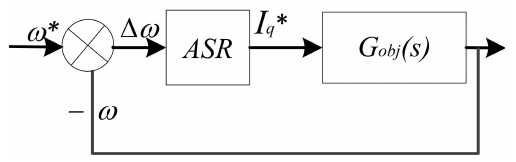
Figure 2. The equivalent control